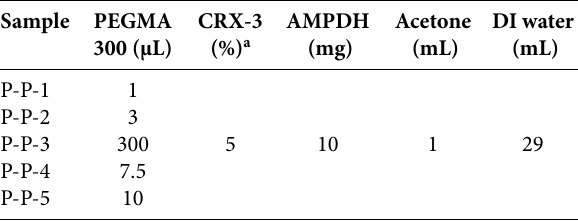
Table 1. Synthesis conditions for PEGMA particles. Sample PEGMA CRX-3